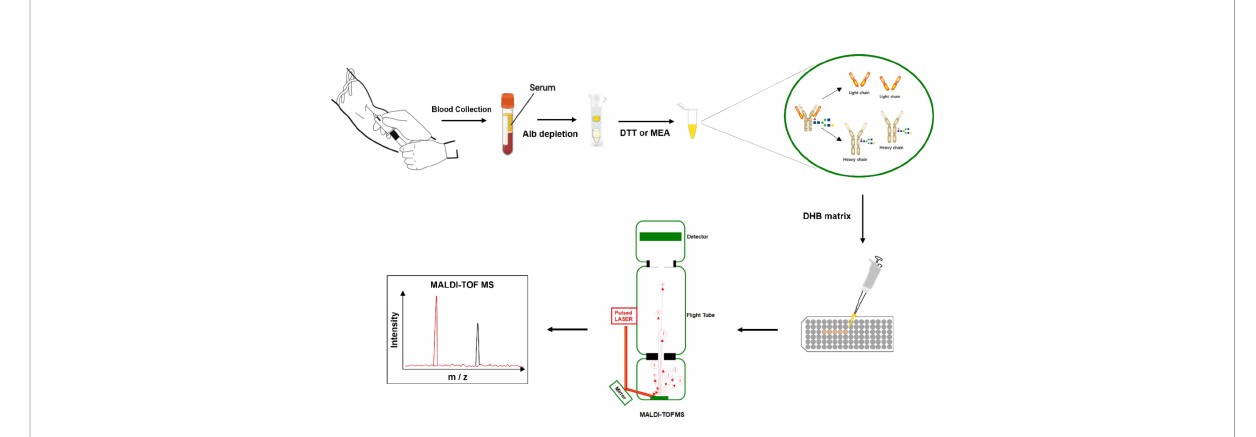
FIGURE 1 Work fl ow diagram of the MALDI-TOF MS method for the screening test of M- protein in